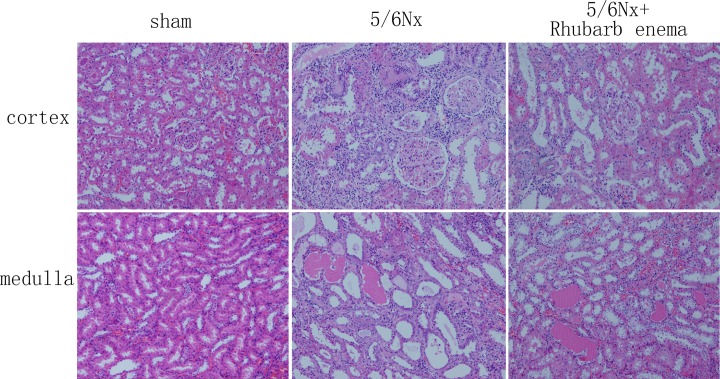
Pathological findings in the sham operation group and the 5/6 nephrectomized rats treated with or without rhubarb enema (hematoxylin and eosin stain, ×100).